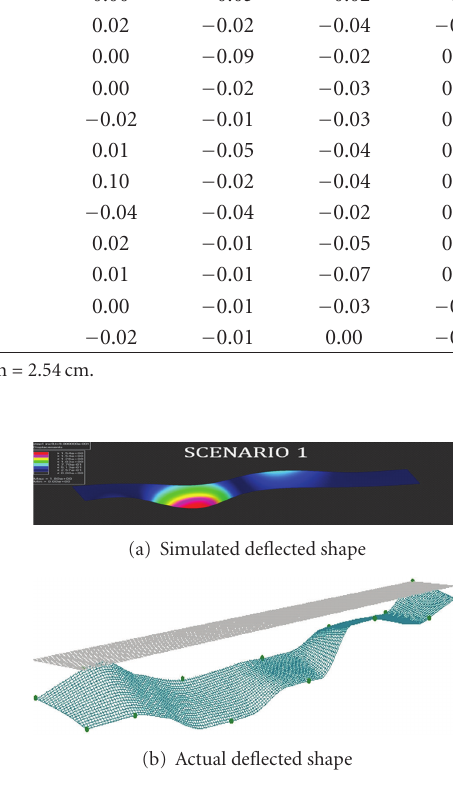
Figure 6: Validating scenario 1 results (not drawn to